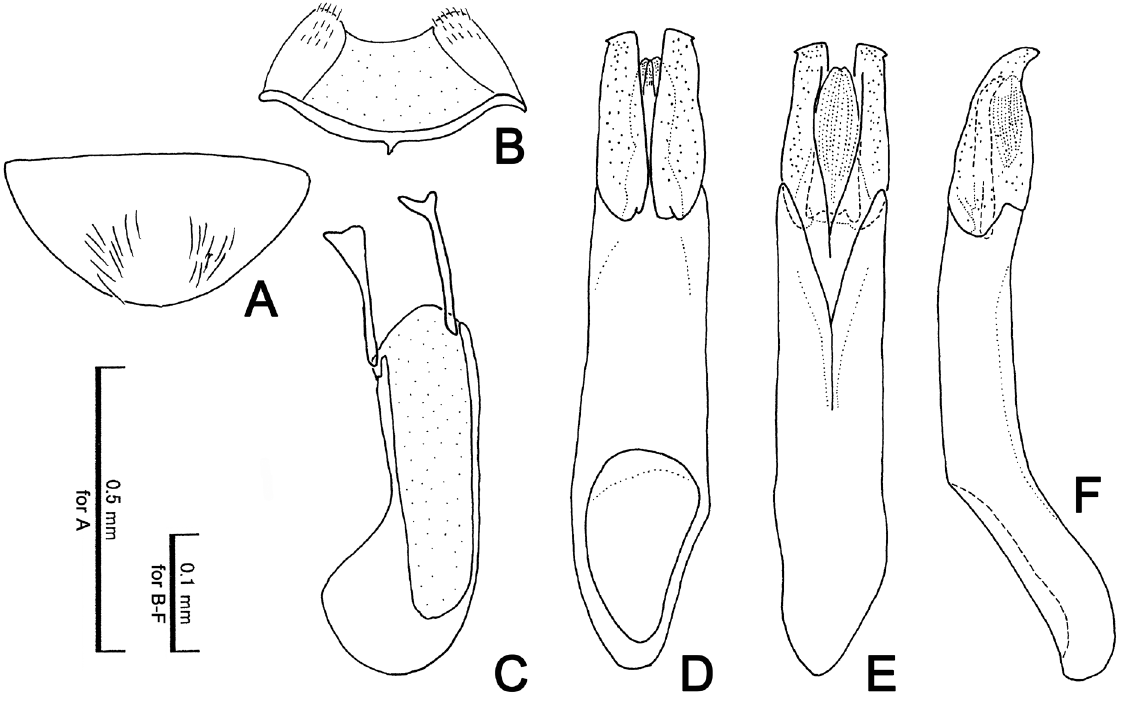
Fig. 8. Acontosceles zetteli Pütz, 2008, male genitalia (BPBM). A . Sternite VII. B . Sternite VIII. C . Sternite IX. D . Aedeagus, dorsal view. E . Aedeagus, ventral view. F . Aedeagus, left lateral